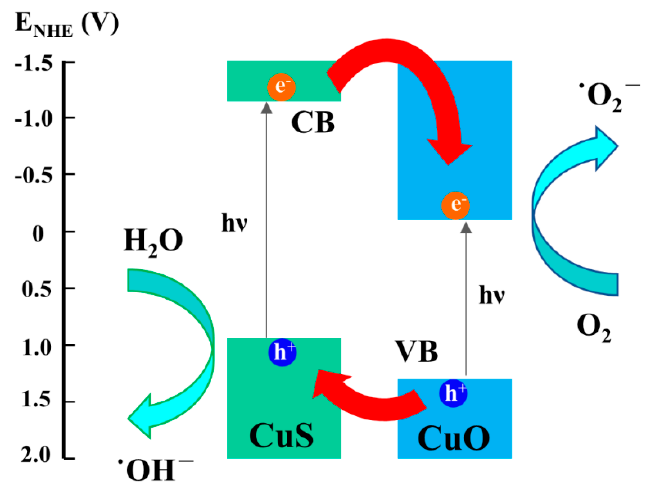
Figure 8. Schematic illustration of photocatalytic mechanism for the CuO-CuS nanowire heterostructure.